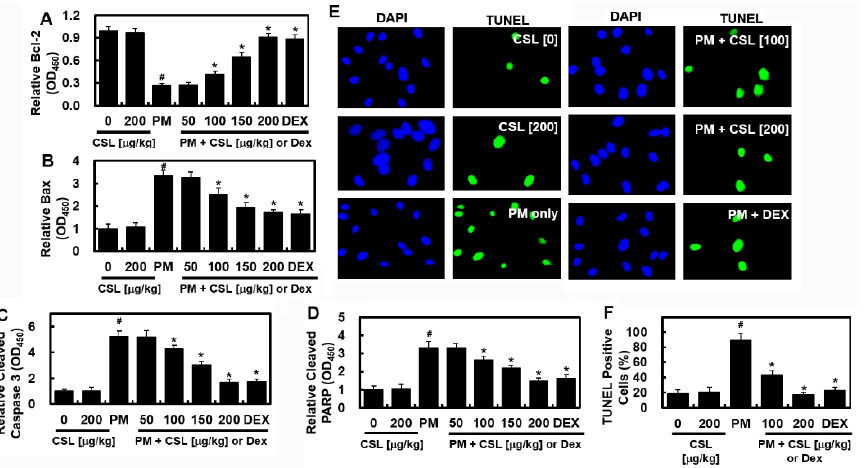
Figure 3. Effects of CSL on PM 2.5 -induced apoptosis. The levels of ( A ) Bcl-2, ( B ) Bax, ( C ) cleaved caspase 3, and ( D ) cleaved PARP were determined using ELISA. ( E ) TUNEL staining of apoptotic cells in lung tissues ×200, and ( F ) the apoptosis ratio. Values represent the mean ± SD of three independent experiments. * p < 0.01 versus the PM 2.5 -challenged group. # p < 0.01 versus the control group.